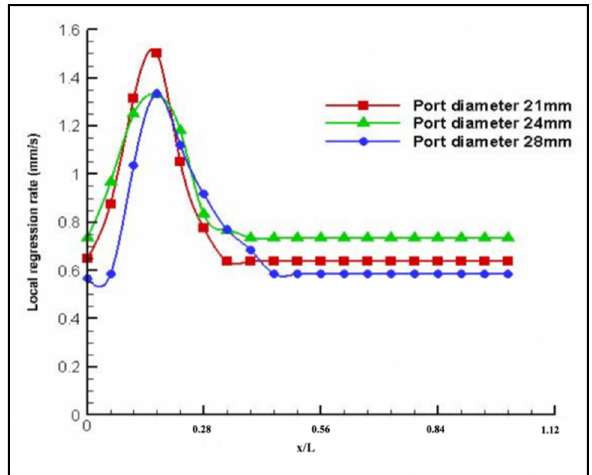
Figure 9. Local regression rate vs. x/L using multi-angle diverging injector by varying port diameter.